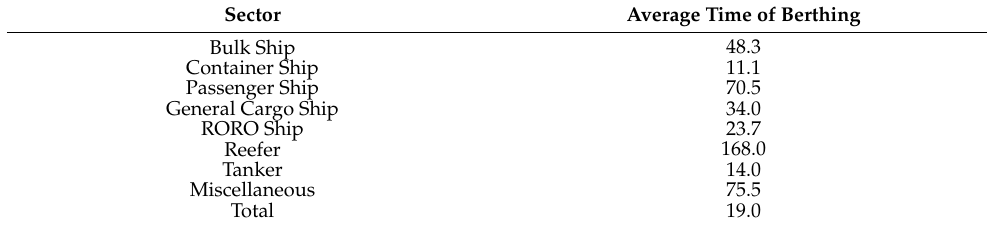
Table 4. Average time of berthing by ship type.